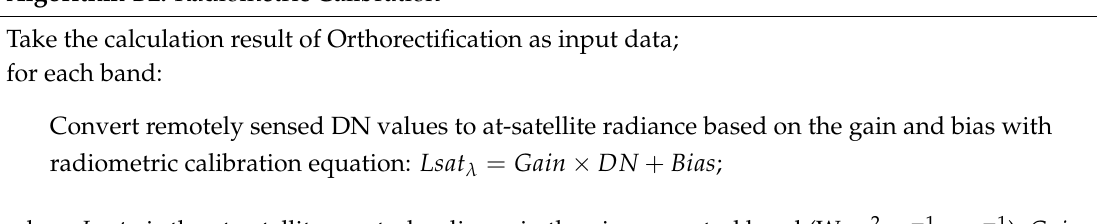
Algorithm B2. Radiometric Calibration